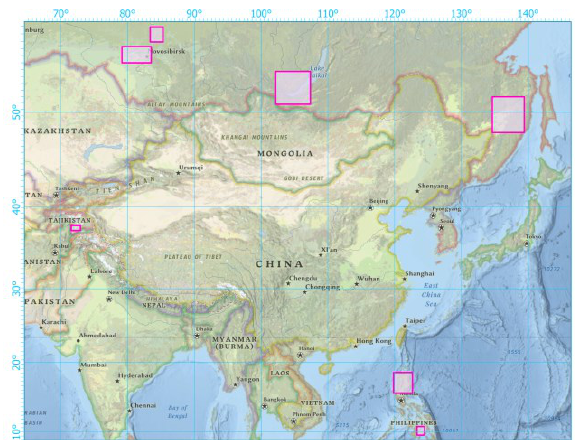
Figure 1 . Data collection regions.